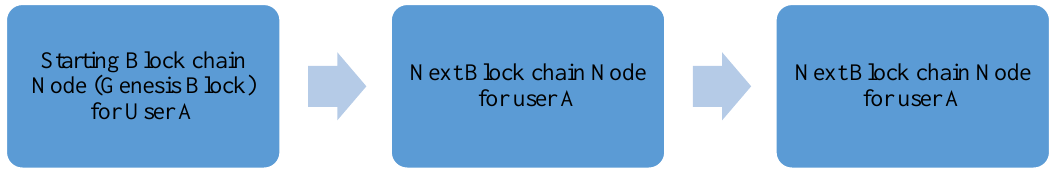
Figure 1. Blockchain starting from new node (genesis block).